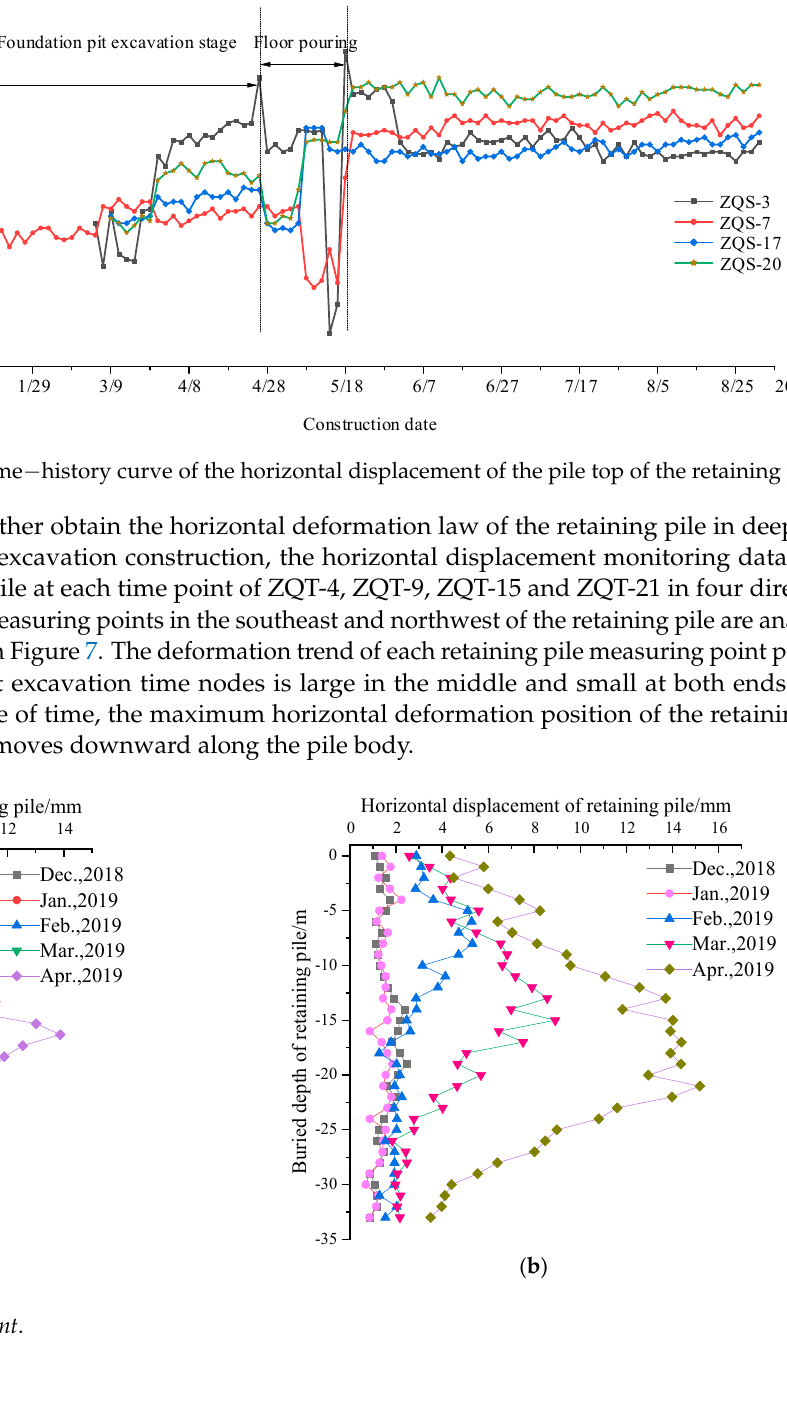
The measured horizontal displacement data of the four direction measuring points ZQS-3, ZQS-7, ZQS-17 and ZQS-20 of the retaining pile are selected for analysis, as shown in Figure 6. During the excavation and construction of the foundation pit in each stage, the horizontal deformation trend of the retaining pile top is toward the inner side of the foundation pit (the value toward the inner side of the foundation pit is positive, and the value toward the outer side of the foundation pit is negative), and it shows a continuous rise. The maximum horizontal displacement of the retaining pile top occurs at the ZQS-3 measuring point, which is 6.2 mm. In the floor pouring stage, the horizontal displacement of the retaining pile top has a sudden decrease trend, and the maximum change value reaches 3.5 mm. Horizontal displacement deformation gradually converges, which inhibits the drift of the retaining structure to the inside of the pit.